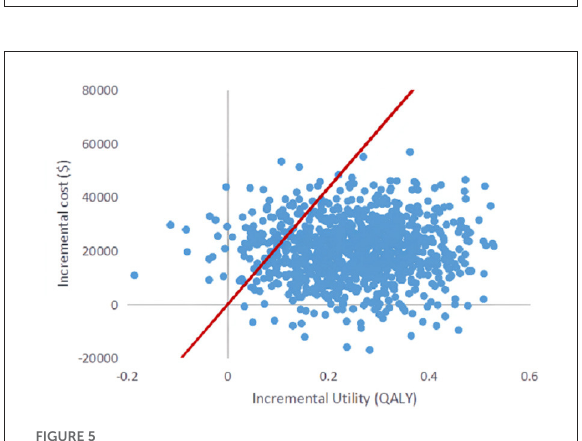
FIGURE5 Scatter plot of incremental